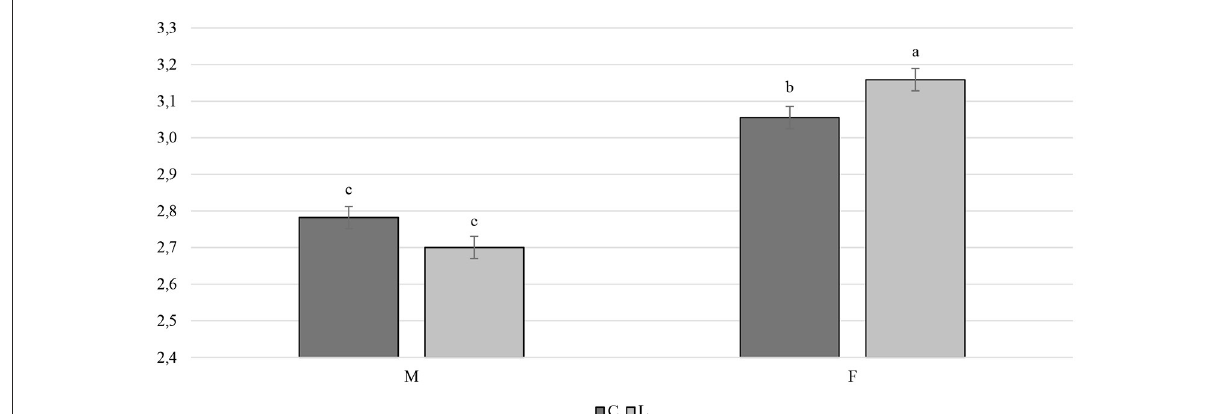
FIGURE1 Interaction effect (gender × diet) on the feed conversion ratio of the Label Rouge Naked Neck birds fed a diet supplemented with 10% live black soldier fly larvae; supplementation based on the expected daily feed intake, (28–81 d; n = 6). a, b indicate significant differences at P < 0.05; F, females; M, males; C, control; L, larvae.